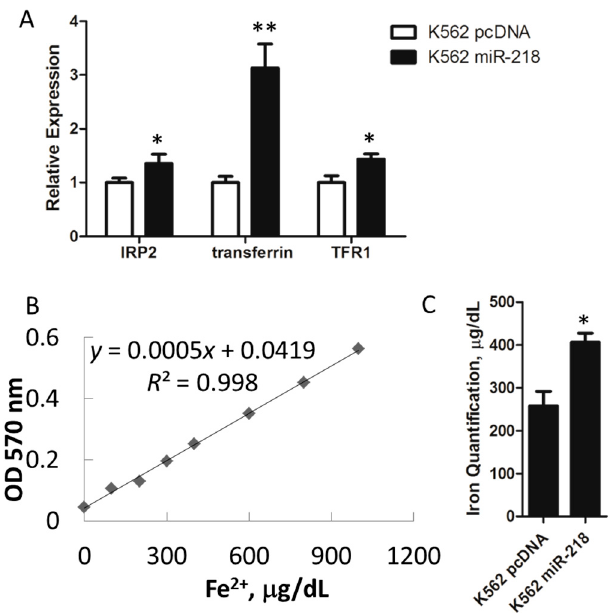
Figure 5. ( A ) Relative mRNA expression of iron metabolism related genes in K562 pcDNA and K562 miR-218 cells using quantitative real-time PCR; ( B ) Standard curve of iron concentration against relative absorption values at OD 570 nm ; ( C ) The iron concentration in the mitochondria of the K562 pcDNA and K562 miR-218 cells was calculated from the standard curve. All relative mRNA expression using quantitative real-time PCR was normalized to GAPDH . Asterisks indicate that differences between samples were statistically significant according to an independent-sample t -test, * p < 0.05, ** p < 0.01.